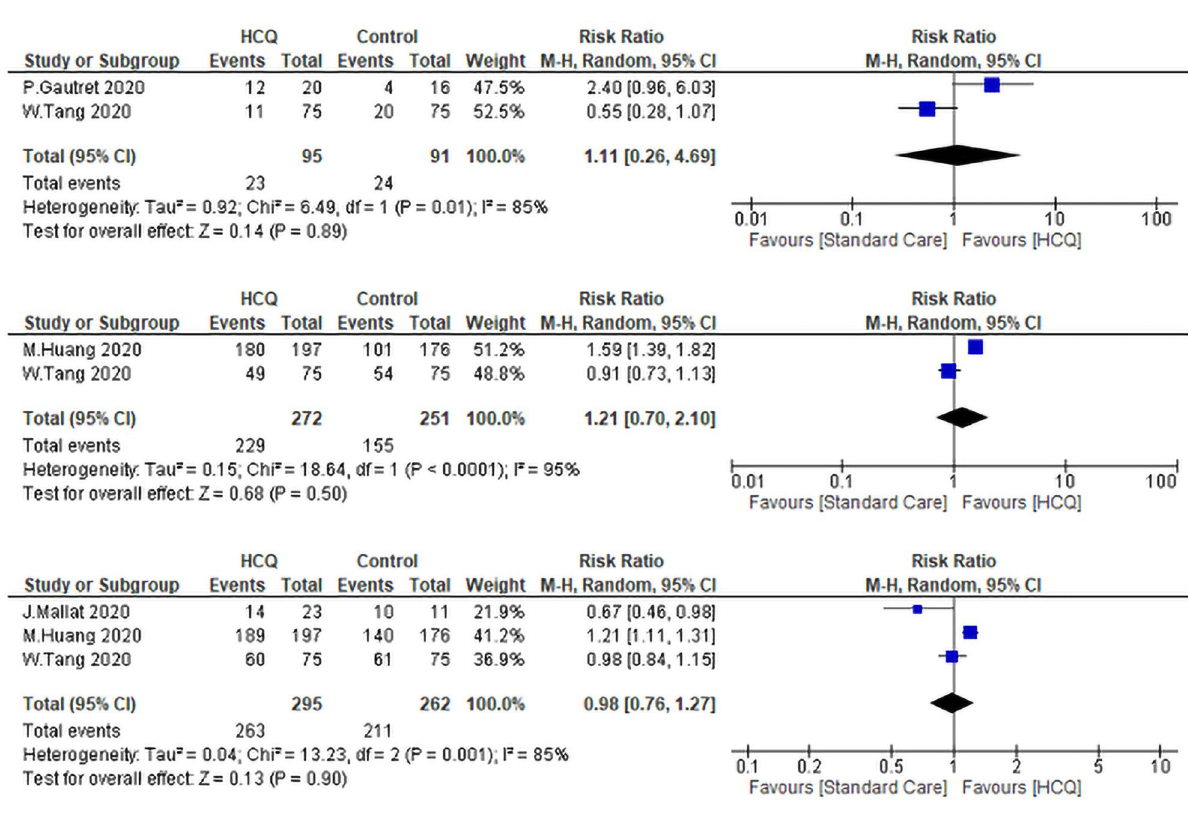
Figure 6. Forest plot for pooling risk ratios regarding virological cure rate on day four, 10 and 14